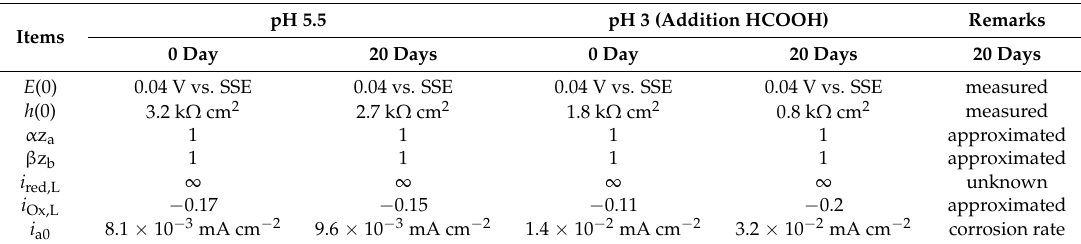
Table 2. Experimental value obtained by reading Figures